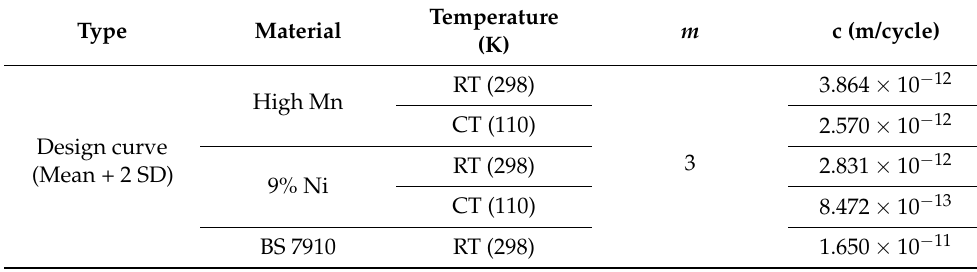
Table 8. Comparison of material constants for the weld